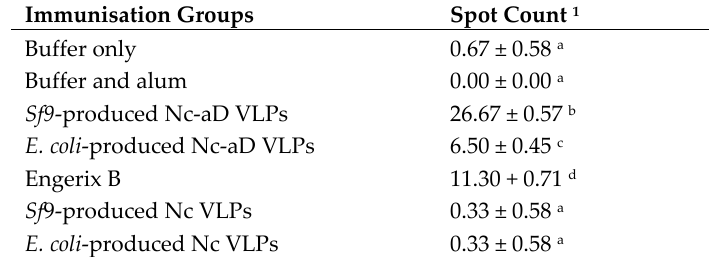
Table 2. Enzyme-linked immunospot (ELISPOT) analysis of activated mice